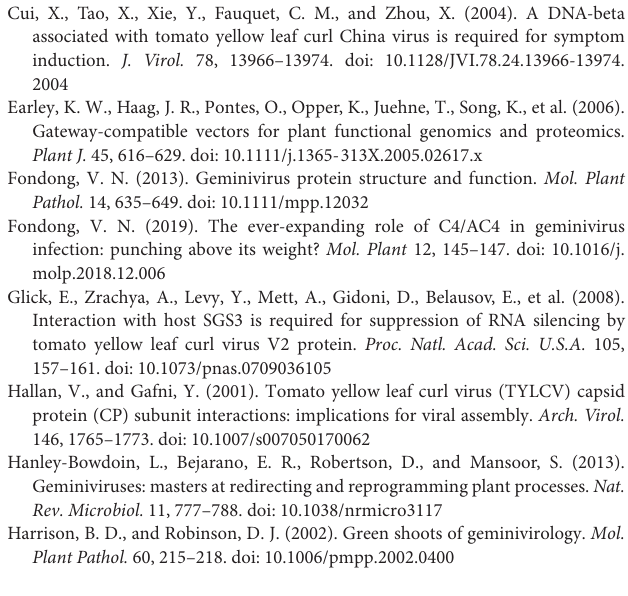
FIGURE S1 | Dynamic changes in the transcripts of viral genes. RT-qPCR analysis of the YFP RNA fused with C1, C2, V1, and β C1. The values of C1-YFP, C2-YFP, V1-YFP, and β C1-YFP at 48 hpi were normalized against NbActin transcripts in the same sample. Three independent experiments, each consisting of three biological replicates, were carried out. Values from one representative result were used to plot a histogram. Statistical analysis was performed using GraphPad Prism 6 software followed by ANOVA using Student’s t -test (two-sided, * P < 0.05, ** P < 0.01, *** P < 0.001). FIGURE S2 | Interaction assays of P3N-PIPO and C1, C2, C3, C4, V2, or β C1. BiFC assays in RFP-H2B transgenic N. benthamiana leaves expressing P3N-PIPO and C1, C2, C3, C4, V2, or β C1 at 48 h post infiltration (hpi). Bars = 20 µ m. No YFP fluorescence was detected. FIGURE S3 | Amino acid sequence alignment of TYLCV-V1 and TYLCCNV-V1 was performed in MegAlign (Lasergene) and sequence distances were conducted in MegAlign using the Clustal V Method. TABLE S1 | Primers used in plasmid construction and other experiments in this